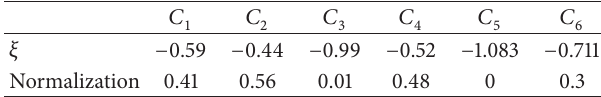
Normalization 0.41